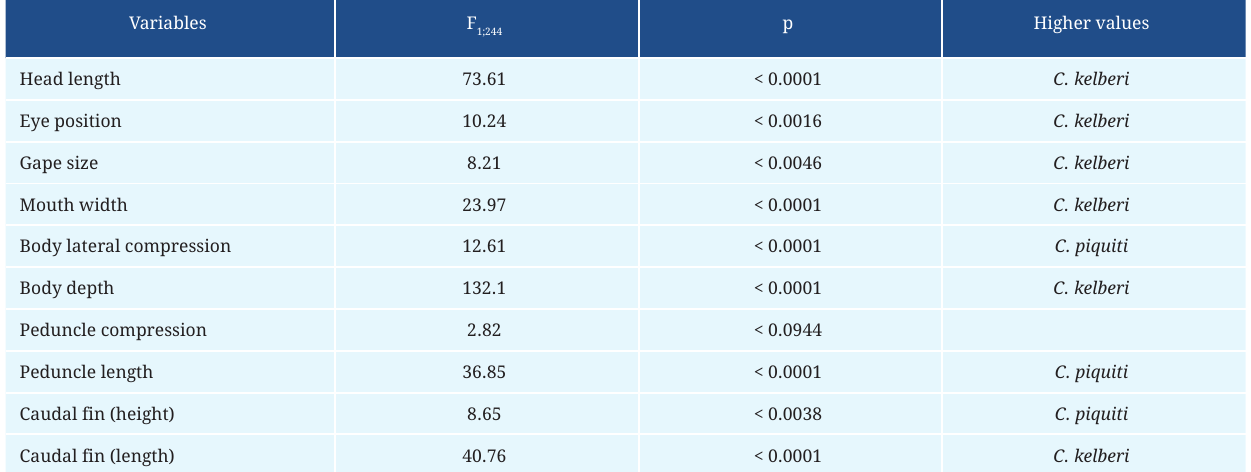
Variables Higher